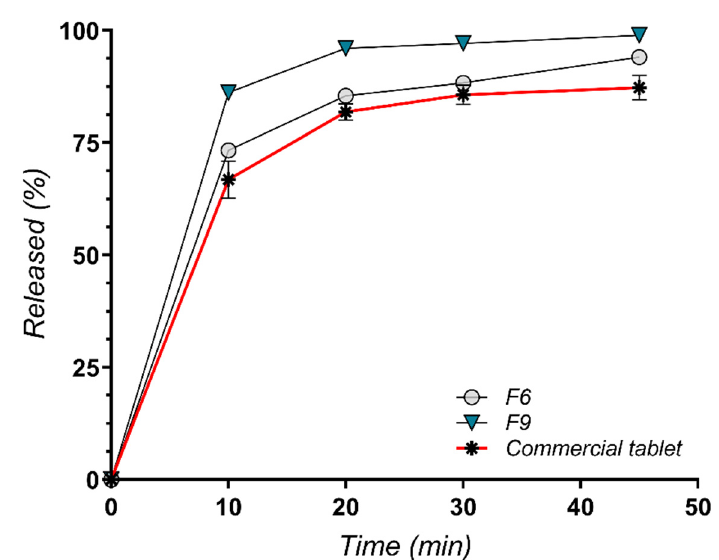
Figure 12. Dissolution profiles for formulations F6, F9 and commercial preparation.